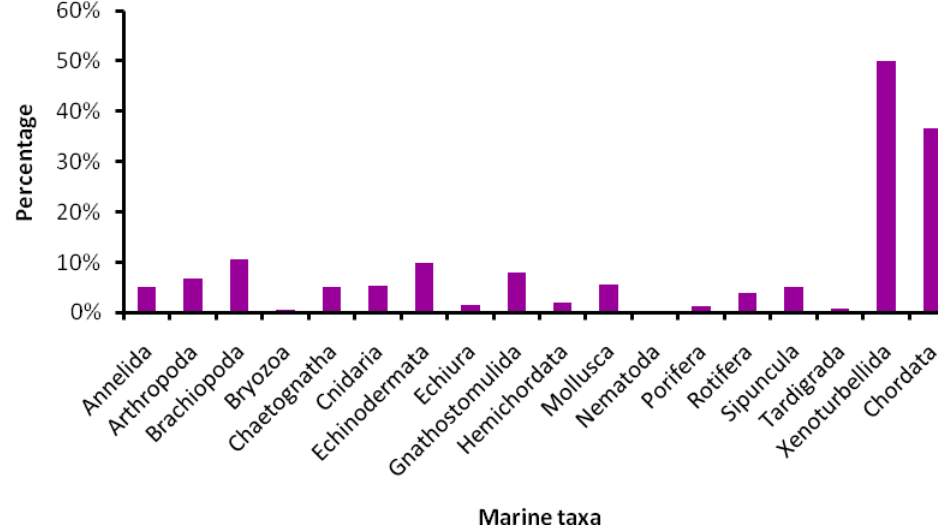
Figure 3. Proportion of barcoded species across marine taxa (data provided by D. Steinke, MarBOL